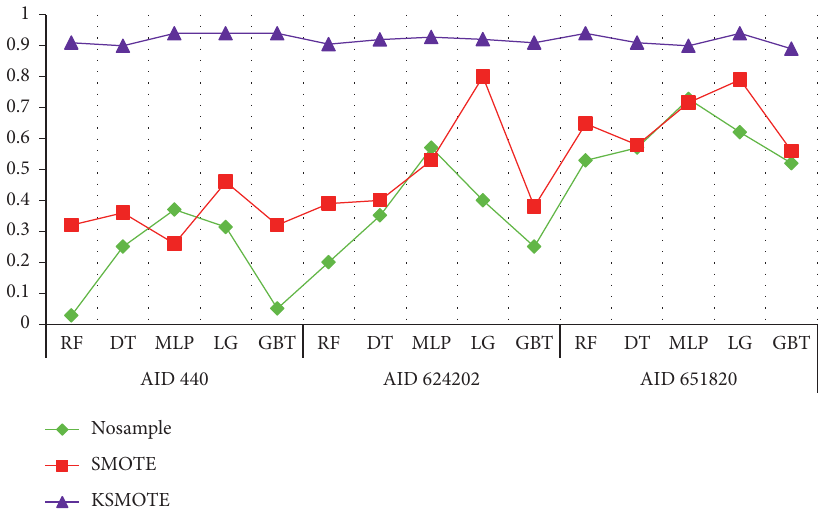
Figure 7: Sensitivity of all datasets for the PaDEL numeric